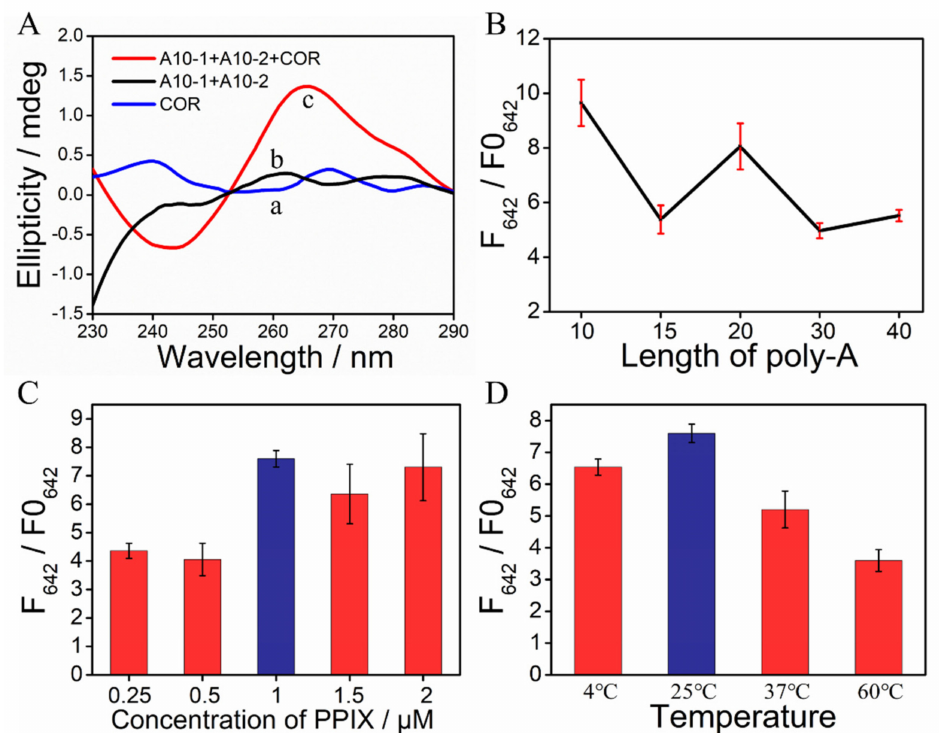
Figure 2. ( A ) CD spectra of (a) solely COR and A10 strands in the (b) absence and (c) presence of COR; ( B ) Optimization of the length of poly − A; ( C ) Optimization of the concentration of PPIX; ( D ) Opti- mization of the reaction temperature. The error bars are obtained via three independent